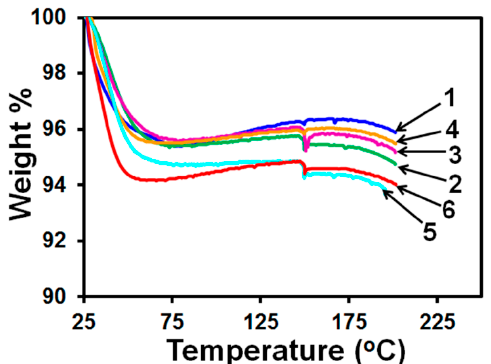
Figure 7. Curves of the HPMC matrix weight percentage vs. temperature for (1–3) (2.5 ± 0.3)-mg porous films with 5 printed 0.5- µ L droplets of 2.5% HPMC-griseofulvin suspension (calculated griseofulvin content 0.45 mg) after overnight storage in a desiccator at room temperature and for (4–6) (2.5 ± 0.3)-mg porous films without the suspension.